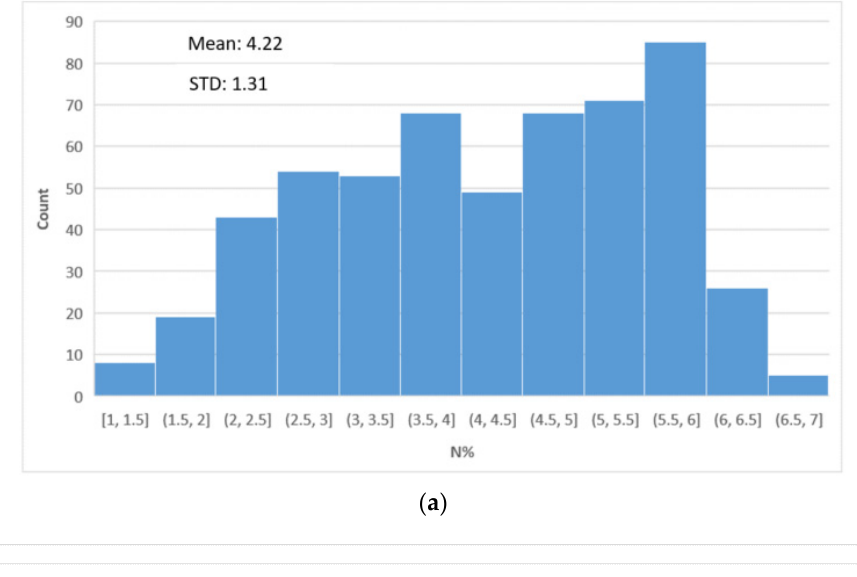
Figure A2. The reflectance data. The different colours represent different levels of N%. ( a ) The reflectance data of ASD FieldSpec 3. ( b ) The reflectance data of FX10 and SWIR cameras in the phenotyping platform. ( c ) The reflectance data of the FX10 labscanner.